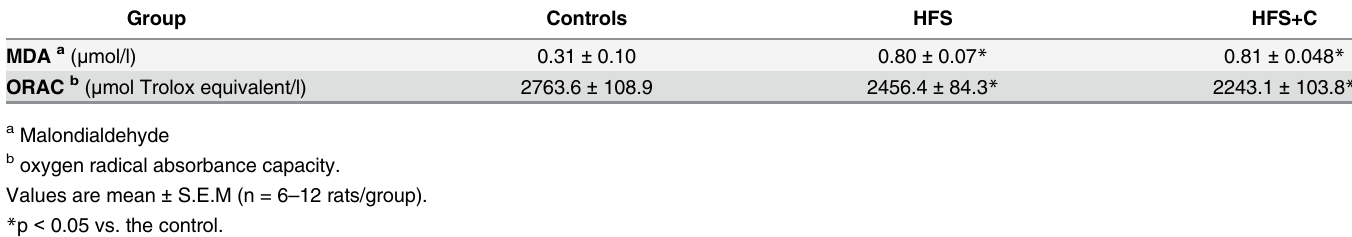
Table. The spectra of serum samples from HFS+C group are dominated by the signals of glucose and lactate, correlated with the hyperglycemia of the rat under high fructose and fat diet. Sig- nals from propylene glycol, a component from the anaesthetic substance used before the sacri- fice of the animals, were at a high concentration in the samples and were not included in the statistical analysis. Table 3. Measurements of lipid peroxidation, total antioxidant capacity of serum after 10 weeks of diet.